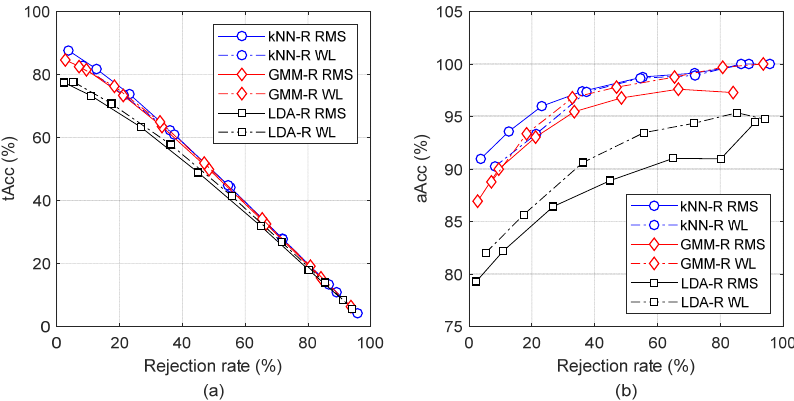
Figure 3. Comparison of classifier performance in recognizing 12 trained movements with different features. ( a ) Average total classification accuracy (tAcc) versus rejection rate. The features applied by different classifiers are root mean square (RMS) and waveform length (WL). ( b ) Average active classification accuracy (aAcc) versus rejection rate.